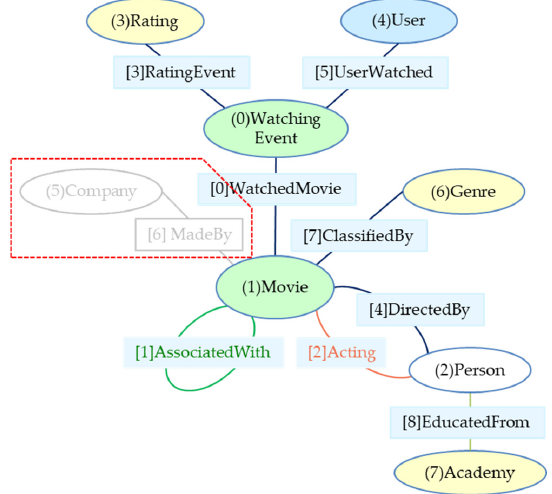
Figure 5. Ontology graph after removing irrelevant graph components.